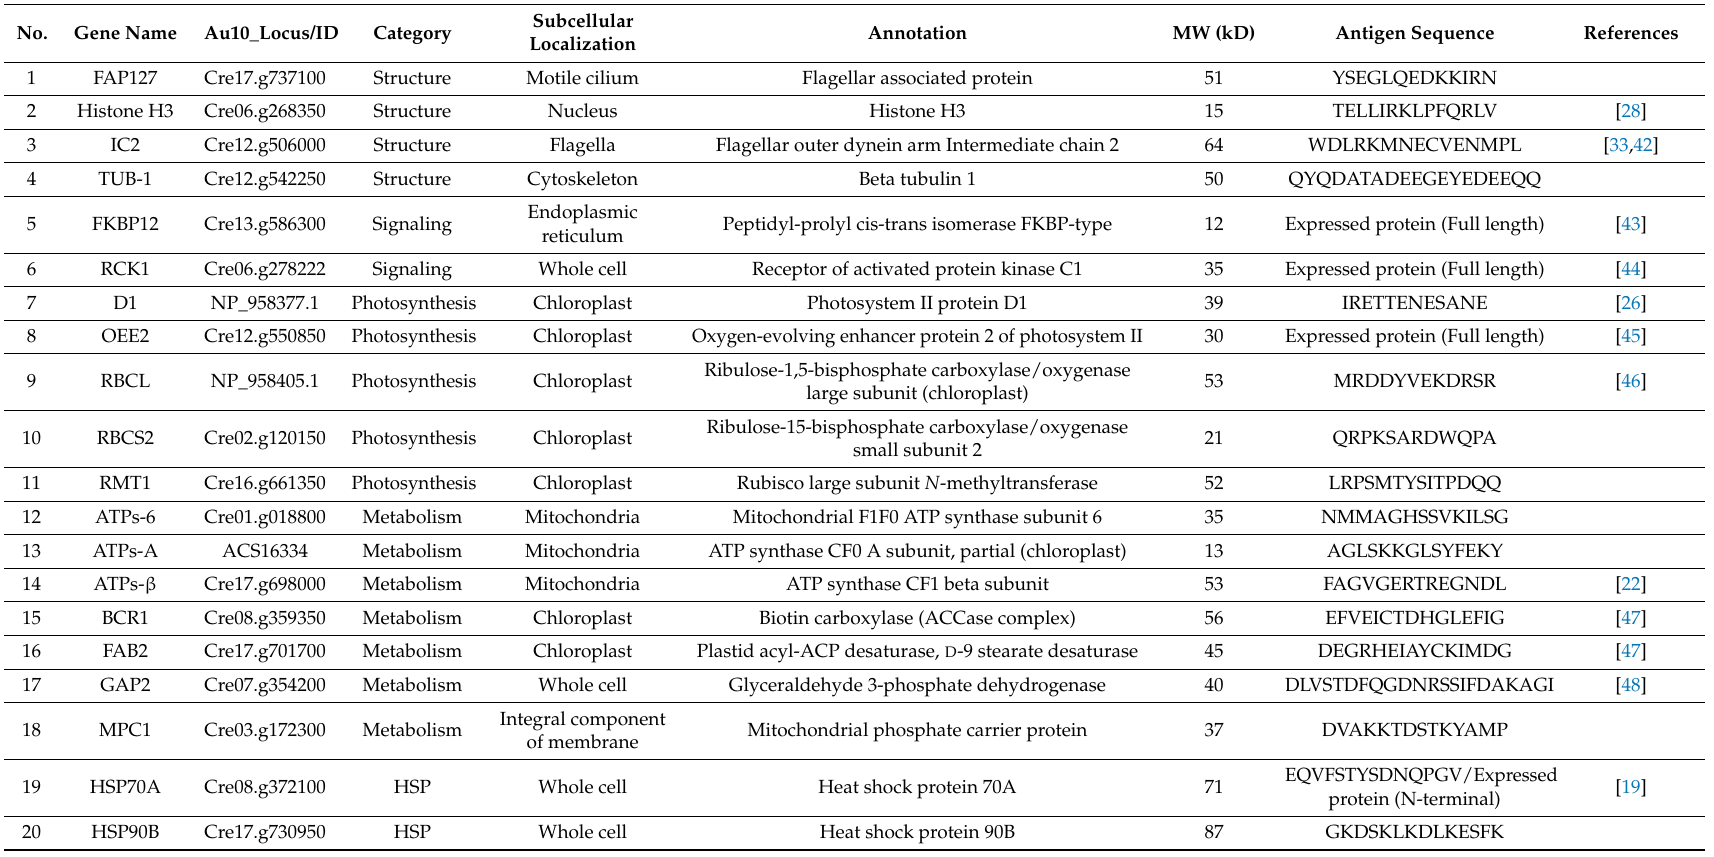
Table 2. List of candidate genes and related